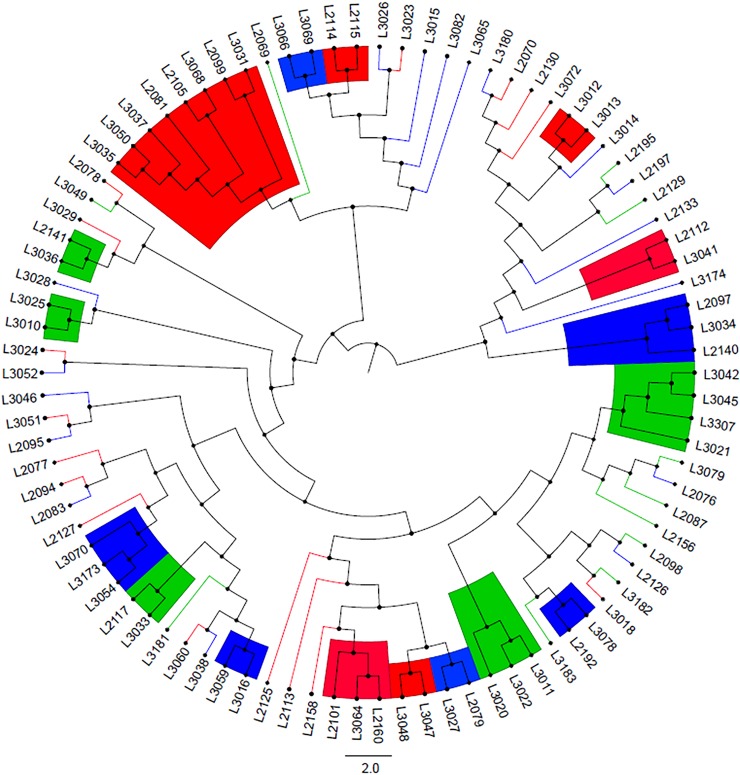
Weighted UniFrac clustering tree of the 90 Thai children individuals.This clustering tree shows the result of weighted UniFrac PCoA plots and visualized the phylogenetic relationship among each salivary microbiome. Each branch represents an individual salivary sample. Samples having similar salivary microbiome compositions are more clustered as highlighted. Green represents Good, blue Moderate and red Poor hygiene branches. Bar length is proportional to phylogenetic distance.